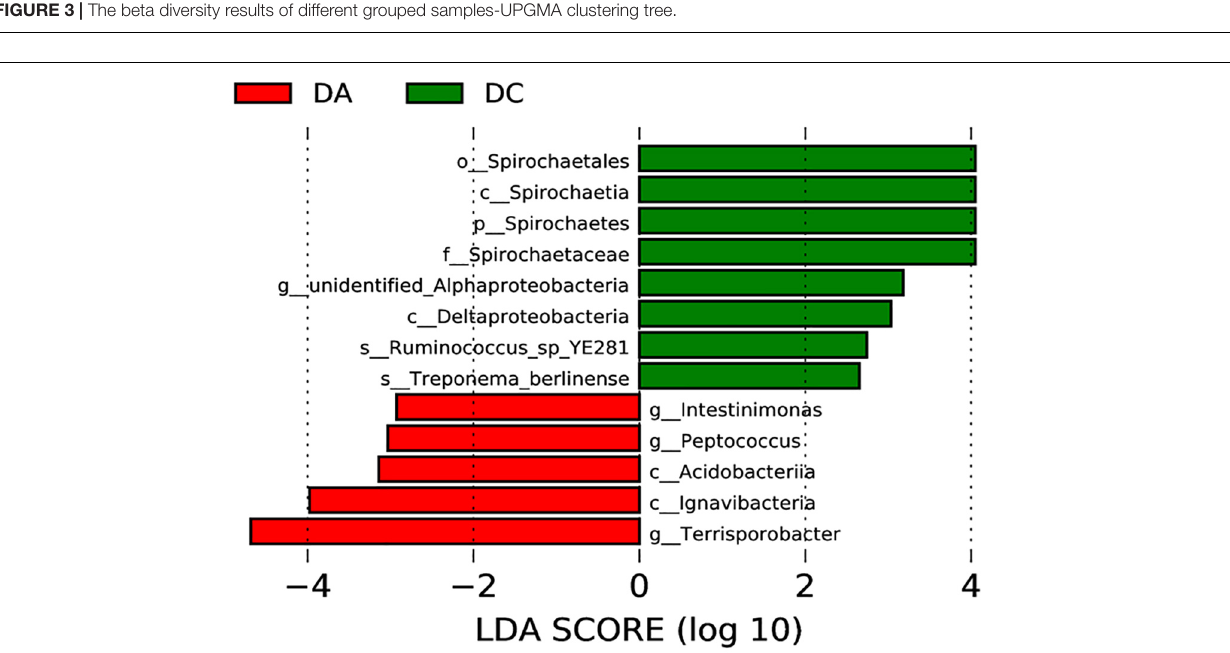
FIGURE 3 | The beta diversity results of different grouped samples-UPGMA clustering tree.